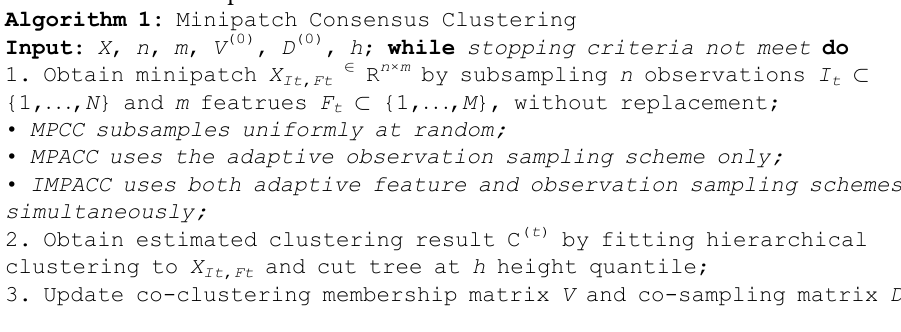
Algorithm 1: Minipatch Consensus